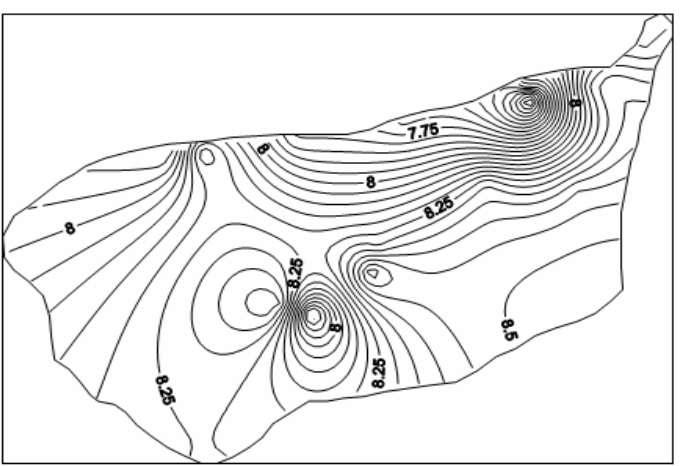
Figure 4. Spatial variation of EC values